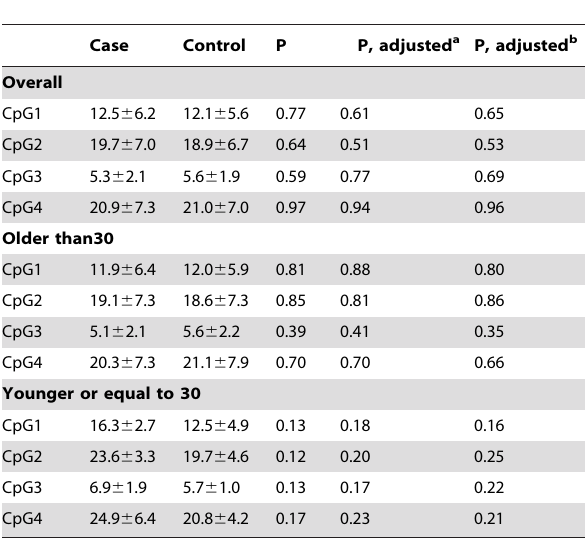
Table 6. Pyrosequencing results of SULF1 gene in the PA cohort.